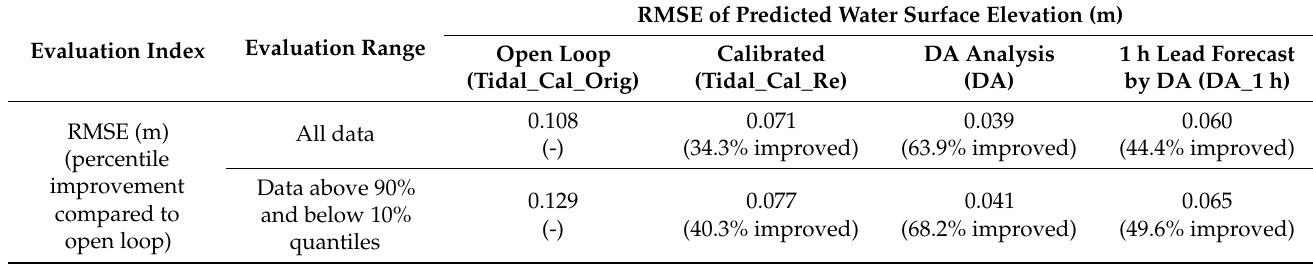
Table 2. Comparison of the performance of the water surface elevation